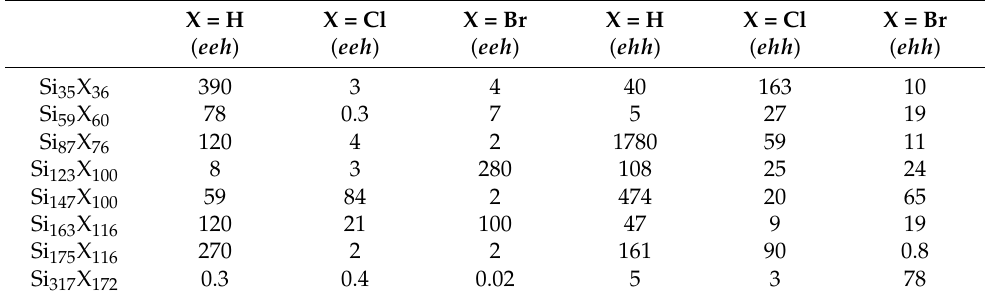
Table 2. Calculated Auger rates ( × 10 10 · s − 1 ) for eeh and ehh processes in halogenated silicon nanocrystals. X = H X = Cl X = Br X = H X = Cl X = Br ( eeh ) ( eeh ) ( eeh ) ( ehh ) ( ehh ) ( ehh